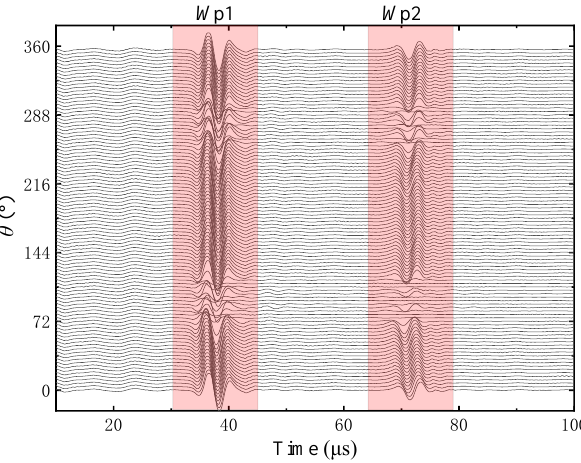
Figure 21. Circumferential echo waveforms for vertical fracture at the same height. The waveforms are windowed and the arrival times of the primary echo Wp1 are extracted by the long and short window energy ratio method. The amplitudes of the primary echo Wp1 are then extracted via the peak-to-peak method. The arrival times and amplitudes of the echo Wp1 are shown in Figures 22 and 23,